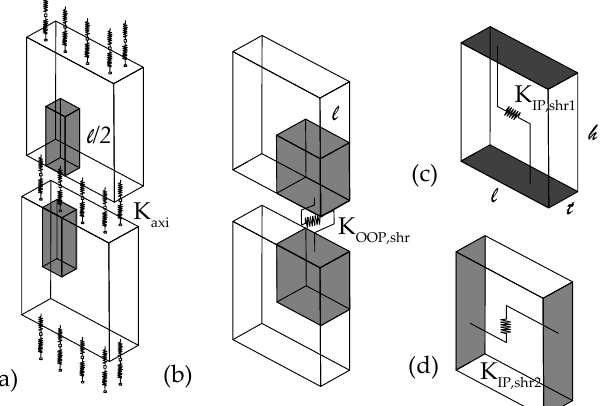
Figure 14. Calibration of the spring elements; ( a ) axial spring; ( b ) out-of-plane shear springs; ( c ) in-plane shear springs for fiber-perpendicular direction; ( d ) in-plane shear springs for fiber-parallel